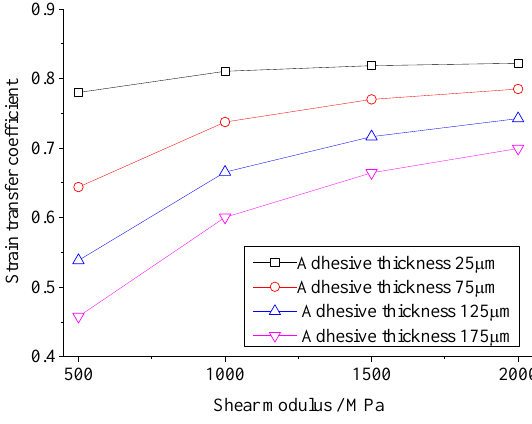
Figure 7. The strain transfer coefficient versus the shear modulus of adhesive in the FEA model.